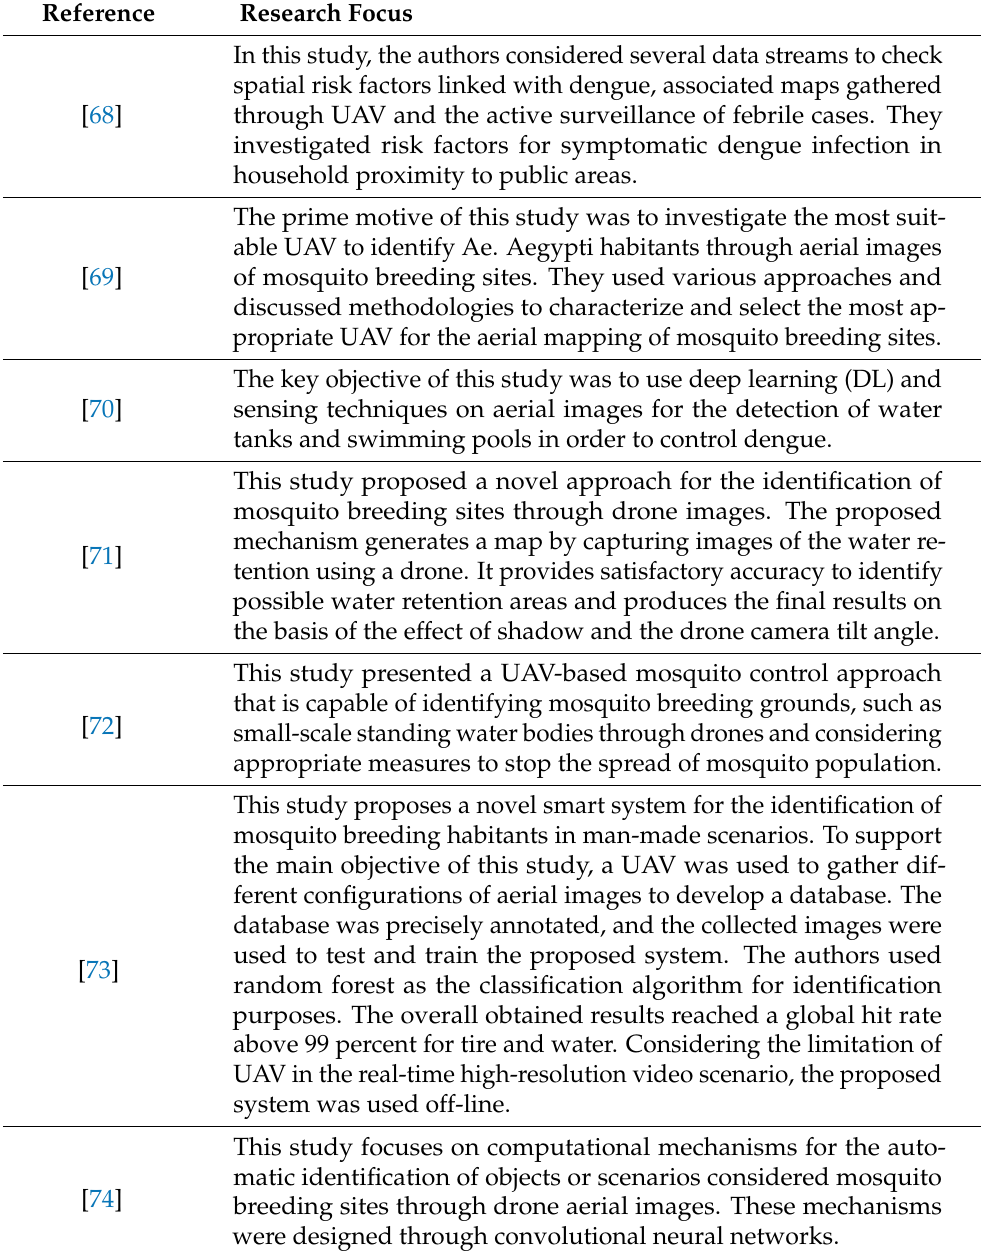
Table 1. Research contributions on the experimental demonstration of UAV for dengue